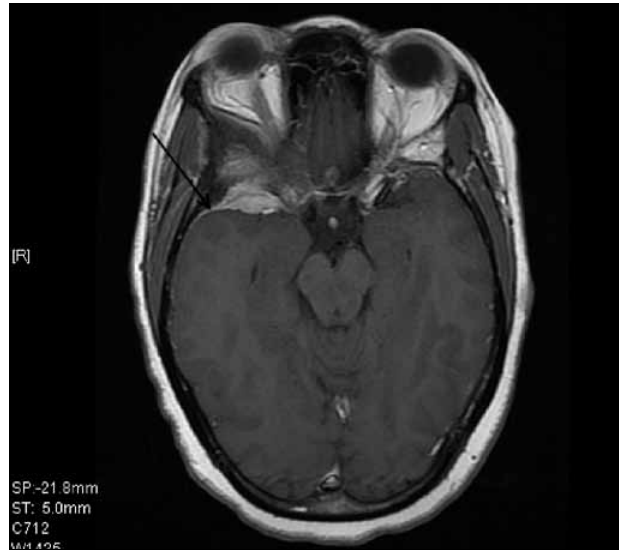
Fig. 1. Axial T1-weighted spin-echo MR image of the brain with intravenous gadolinium demonsrates the dural tail (arrow) i.e. linear thickening and enhancement of the meninges appearing as a tail, attached to a meningioma in the right anterior temporal lobe.